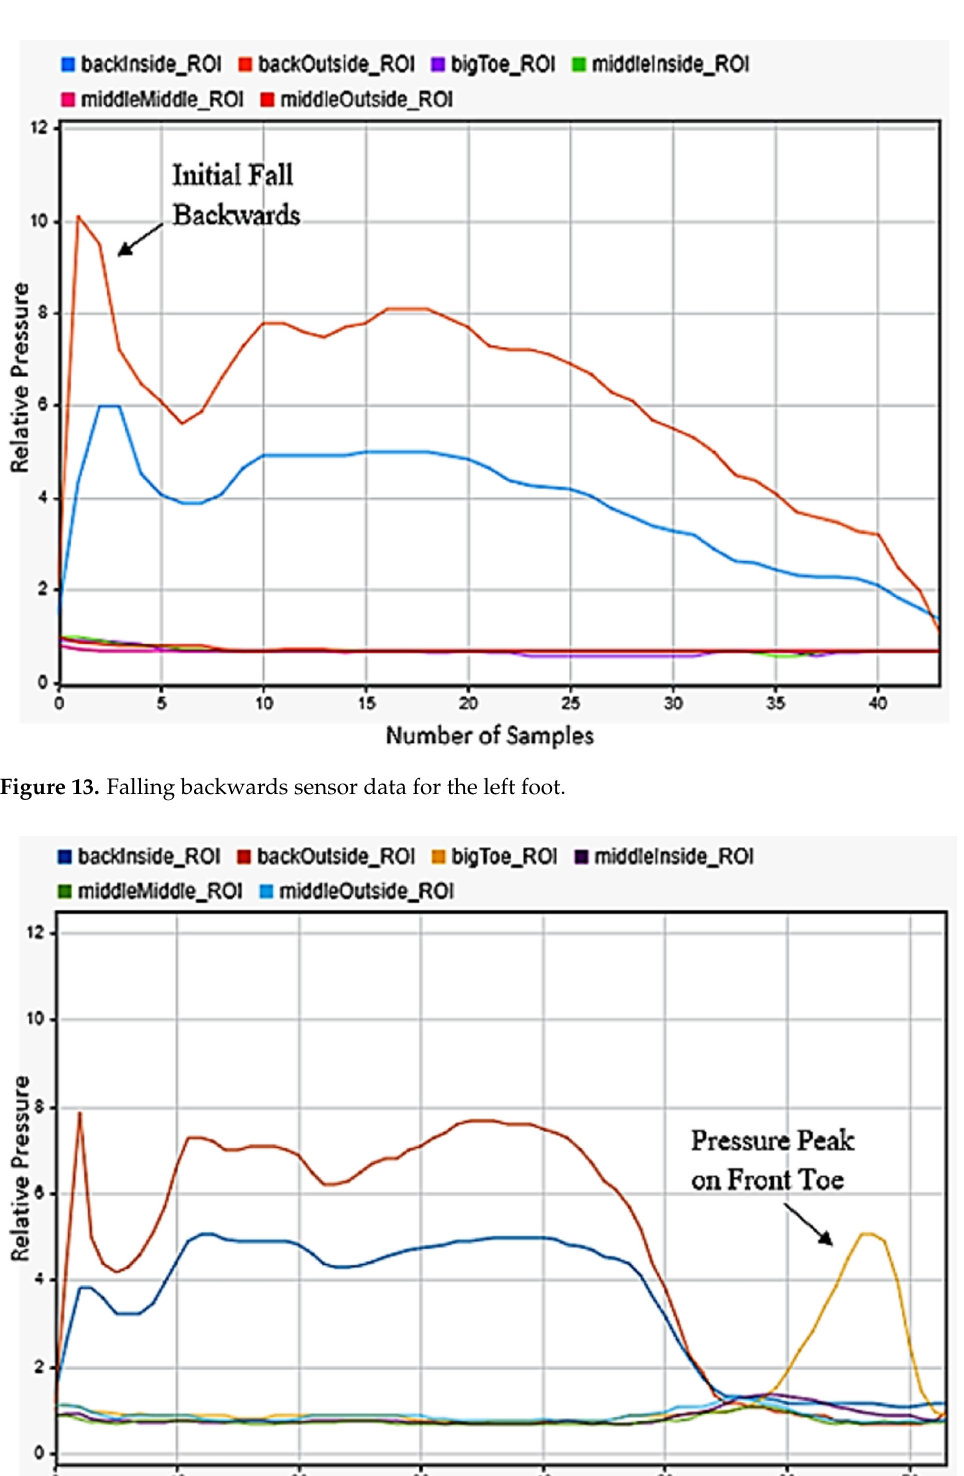
Figure 15. Falling to the left sensor data for the left.